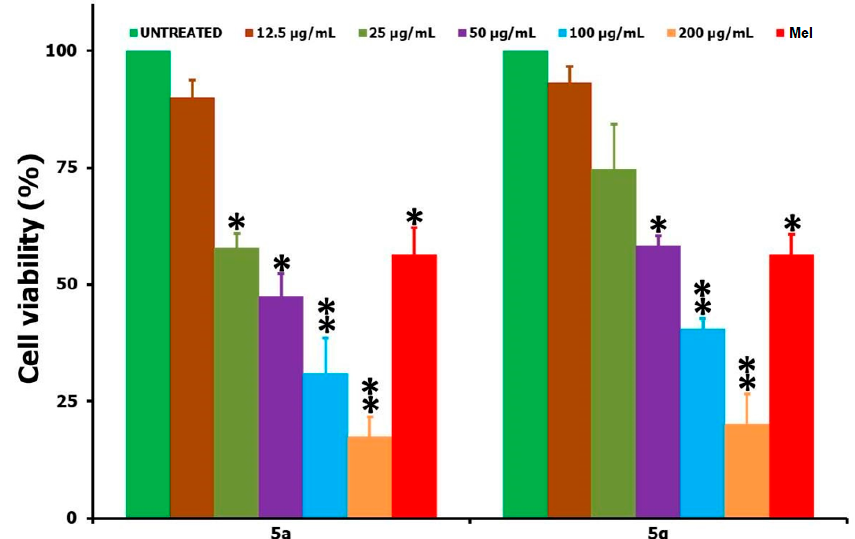
Figure 3. Comparison of the in vitro cell viability studies provided by the MTT assay when the L929 non ‐ cancer cells were treated with 5a and 5g at different concentrations in the range of 12.5–200 μ g/mL for a 24 h period. STD corresponds to Mel (15 μ g/mL); * and ** correspond to the significant ( p < 0.05) and highly significant ( p < 0.01) values, respectively, against the untreated controlled measurements.